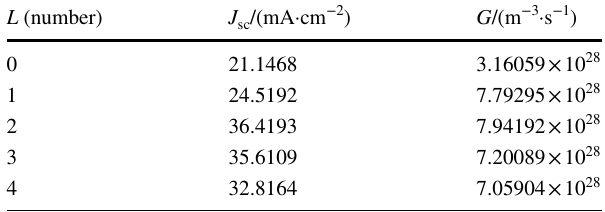
Table 2 Performance of the graphene/Si QDIBSC versus L